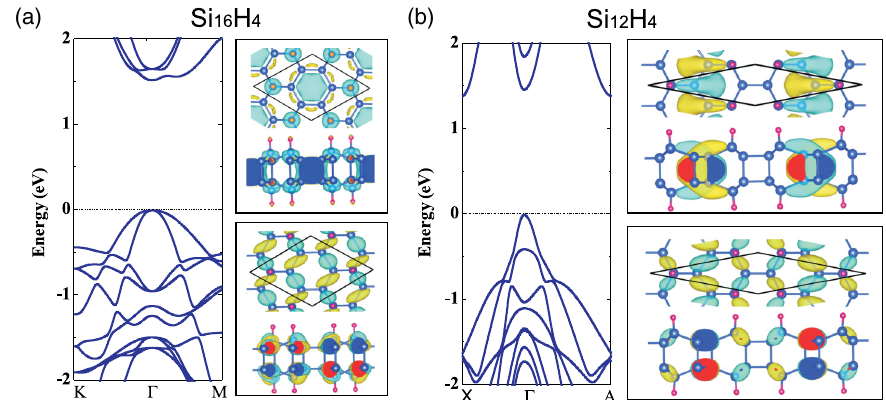
FIG. 7. The calculated band structures of double-sided (a) Si 16 H 4 and (b) Si 12 H 4 . The wave functions of VBM (bottom figure) and CBM (top figure) at the Γ point for each structure are also plotted here. The Fermi level is set to zero.